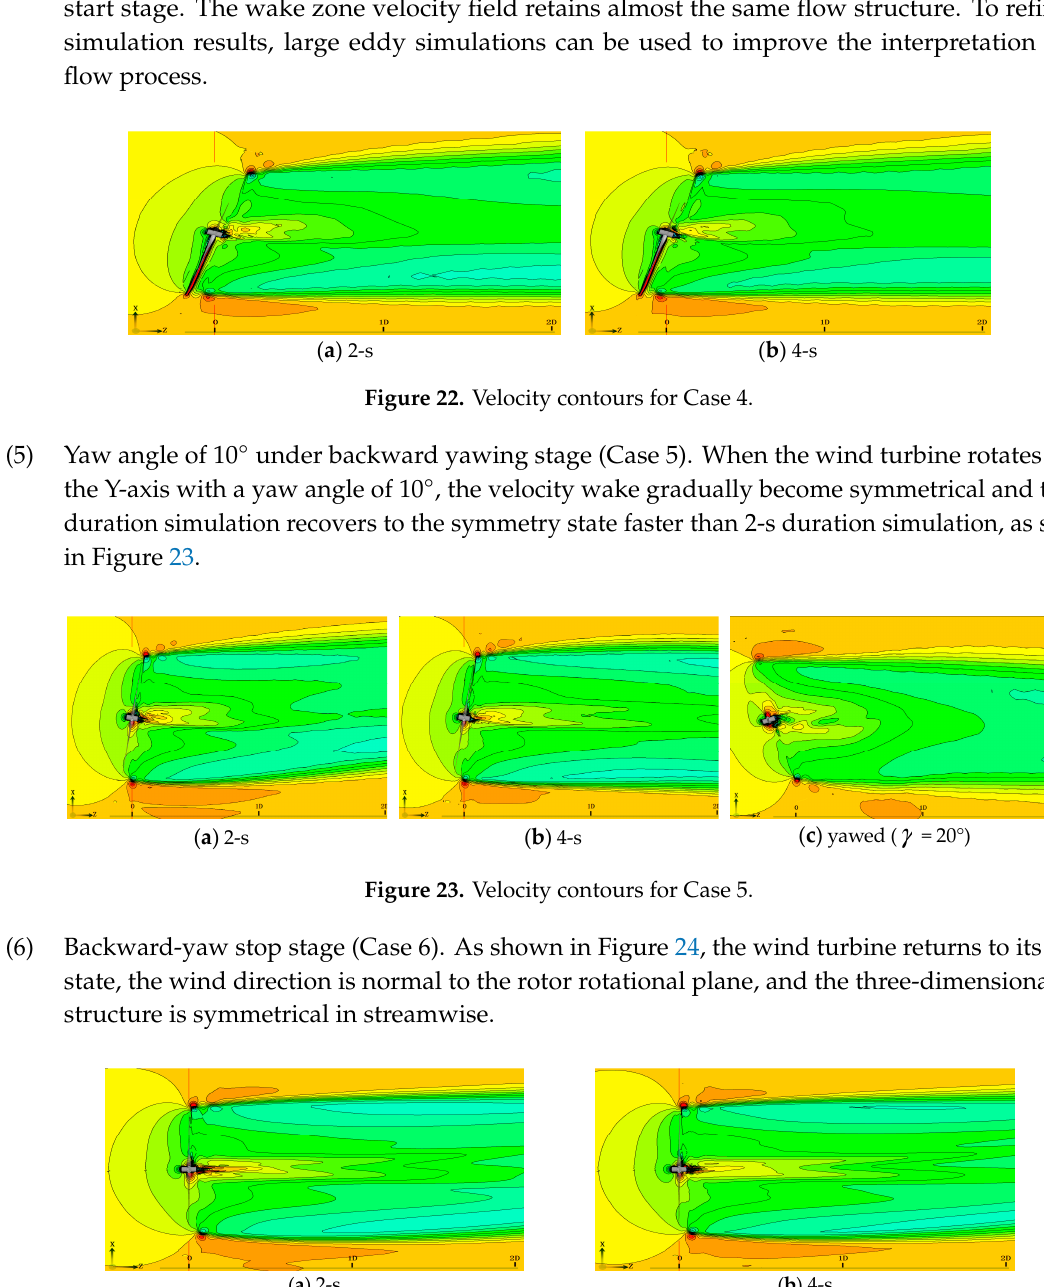
Figure 21. Velocity contours for Case 3.